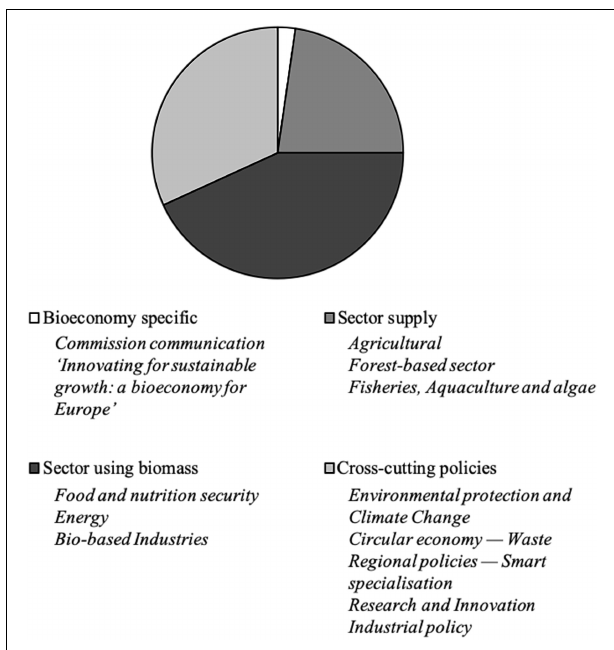
FIGURE 1 | Bioeconomy-related policies and strategies. Description of relevant policies and strategies for the bioeconomy. Based on A sustainable bioeconomy for Europe: strengthening the connection between economy, society and the environment (Updated Bioeconomy Strategy,